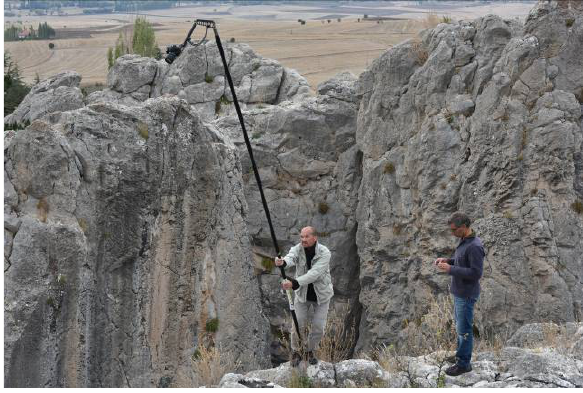
Figure 5. Phases of the PhotoScan procedures